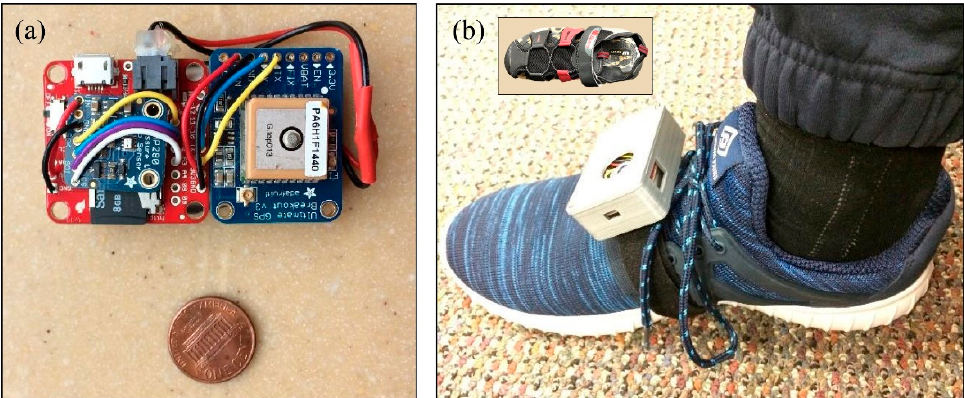
Figure 4. Sensor system used for the pilot study. ( a ) The sensors include a full IMU (9Dof Razor